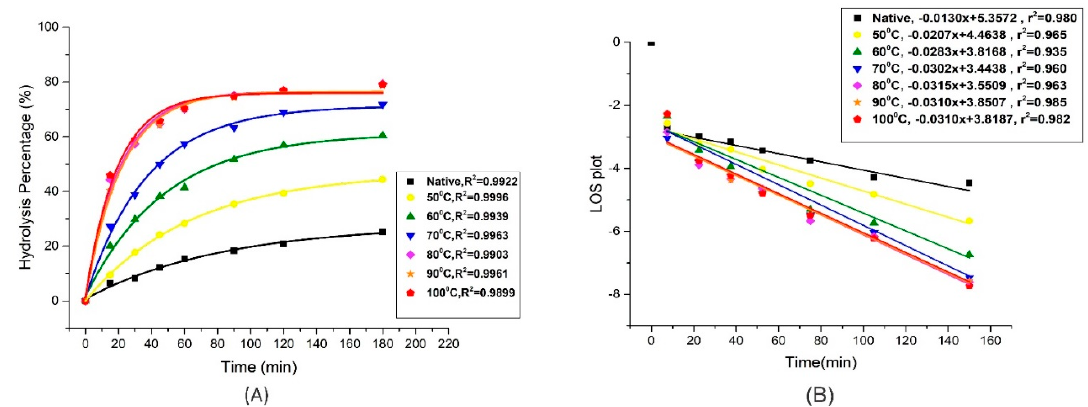
Figure 6. Digestograms of controlled gelatinized mung bean starch showing ( A ) Non-linear curve fitting and ( B ) LOS plots.